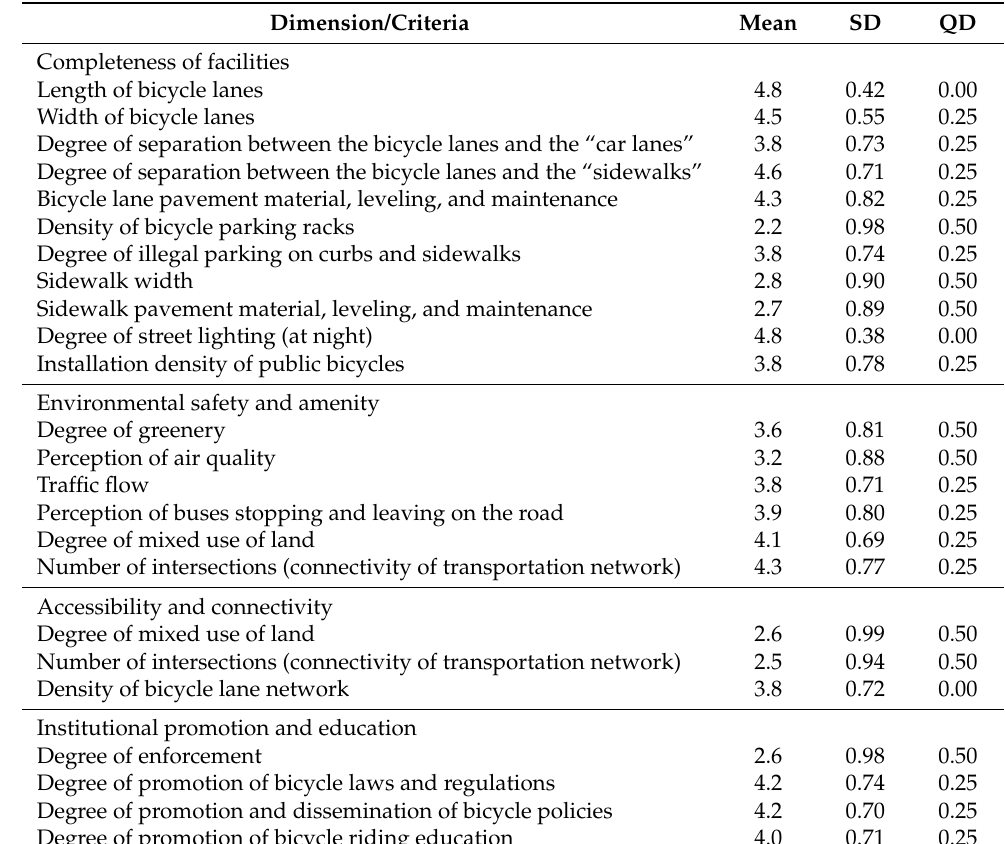
Table 3. Criteria screening in bikeability